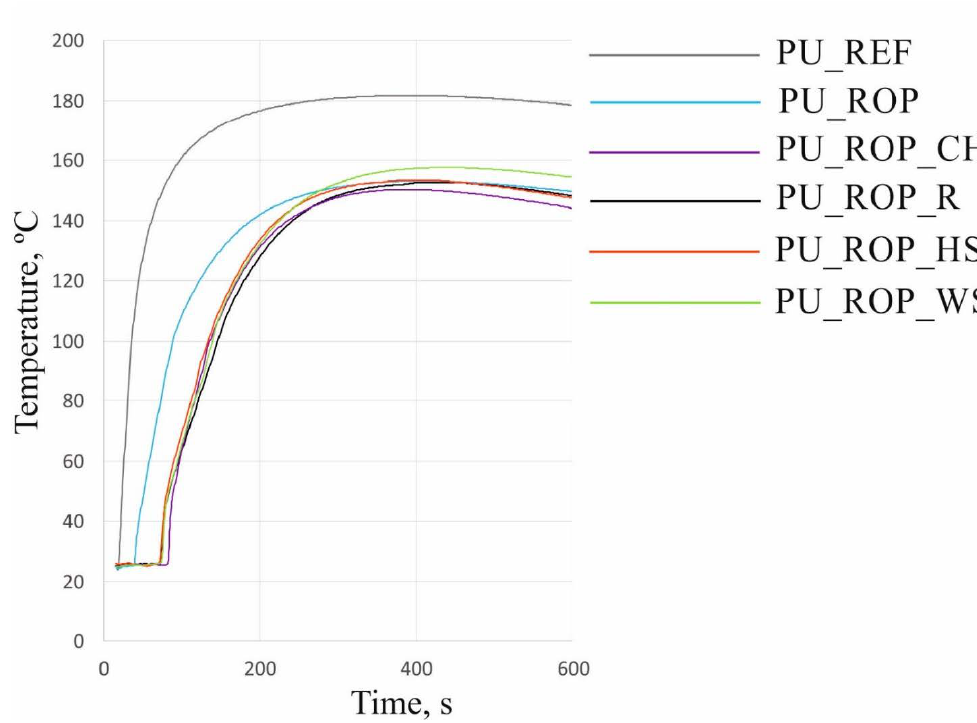
Figure 6. The influence of the ROP and natural fillers on the temperature during the foaming